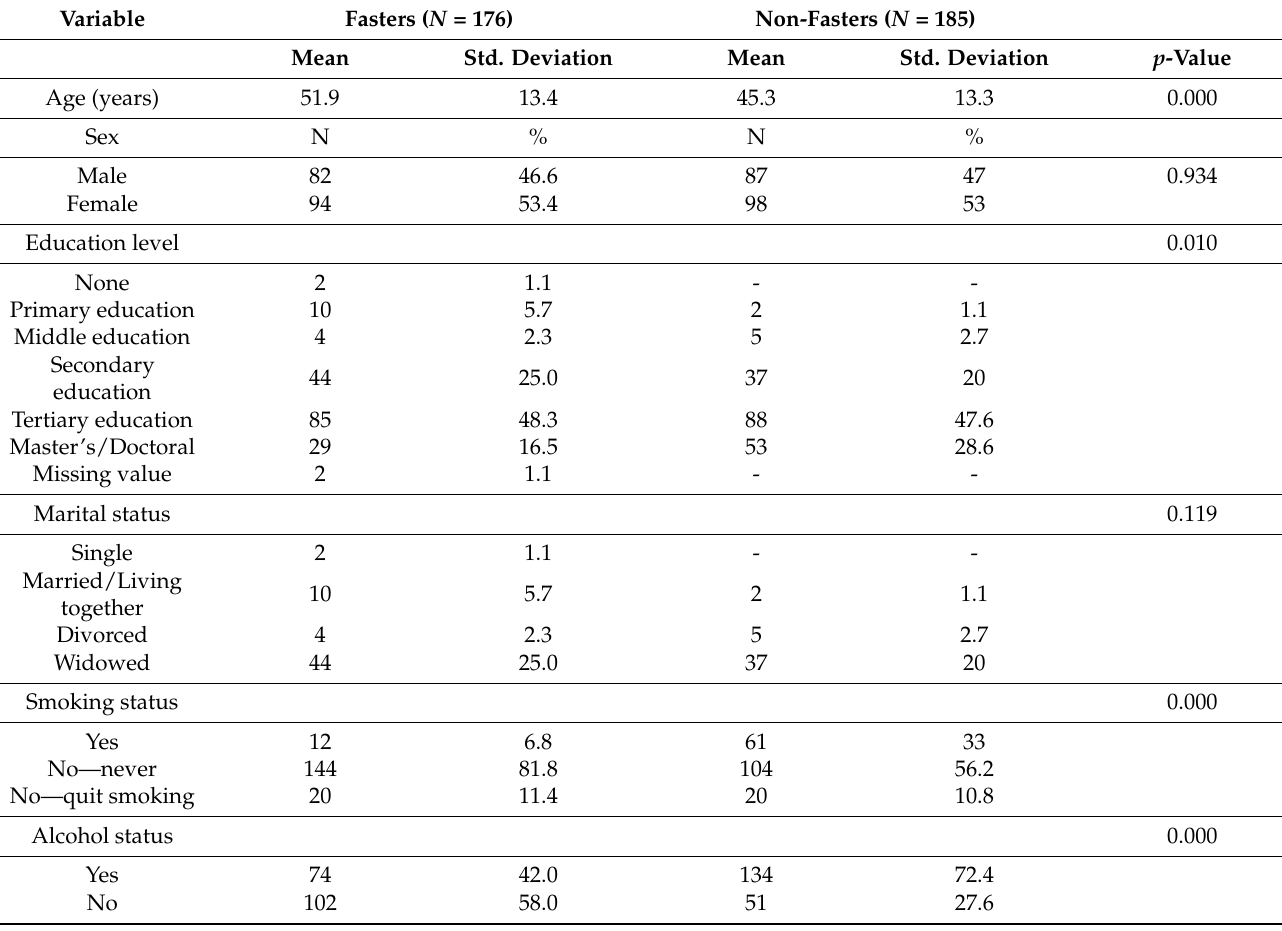
Table 1. Demographic parameters of the two groups.